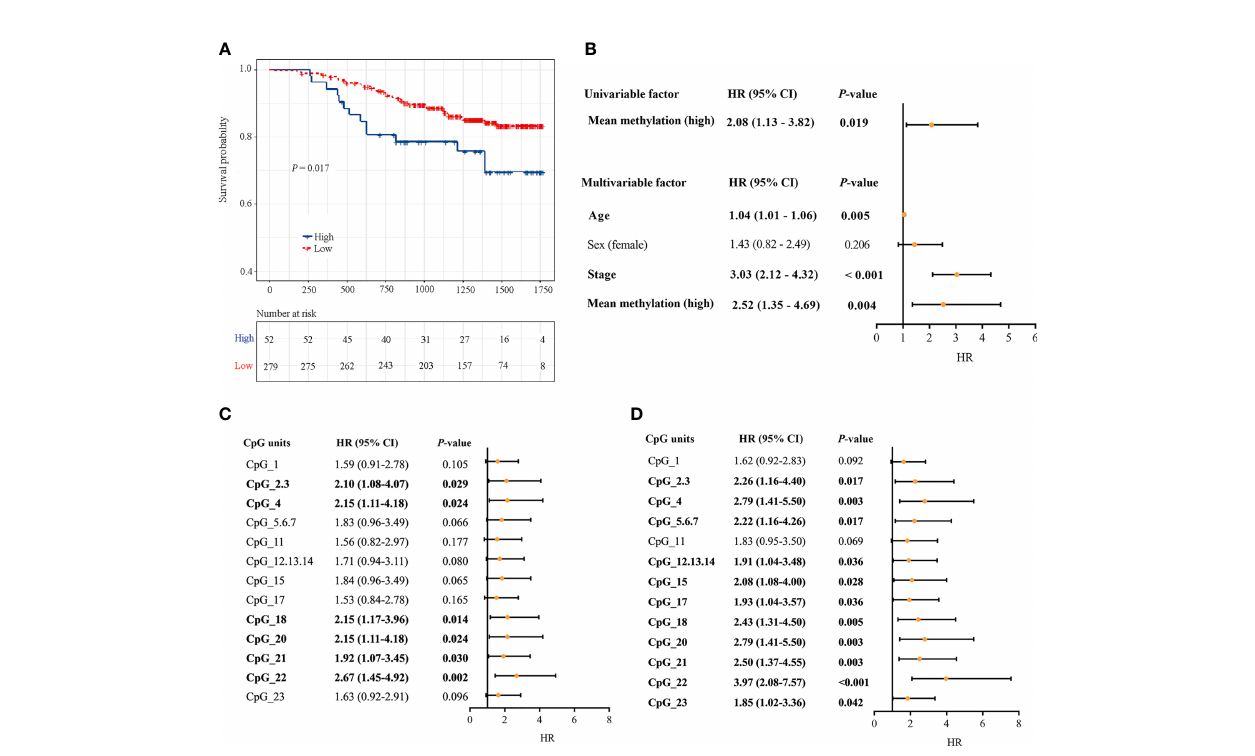
FIGURE 6 | Associations between DLX6-AS1 methylation levels and CRC-speci fi c survival. (A) Kaplan-Meier estimation of the disease-speci fi c survival of the entire set of CRC patients (N = 331) using the mean methylation levels of DLX6-AS1 . The blue line indicates the group with a high methylation level. The red line indicates the group with a low methylation level. (B) Univariate and multivariate Cox regression analysis with the mean methylation level. Multivariate Cox regression analysis were adjusted for age, sex and TNM stage. (C) Univariate Cox regression analysis with the methylation status of individual CpG units within DLX6-AS1 promoter. (D) Multivariate Cox regression analysis with the methylation status of individual CpG units within DLX6-AS1 promoter. Orange solid dots represent the point estimation of the hazard ratio (HR) of disease-speci fi c death, and the open-ended horizontal lines represent the 95% con fi dence intervals